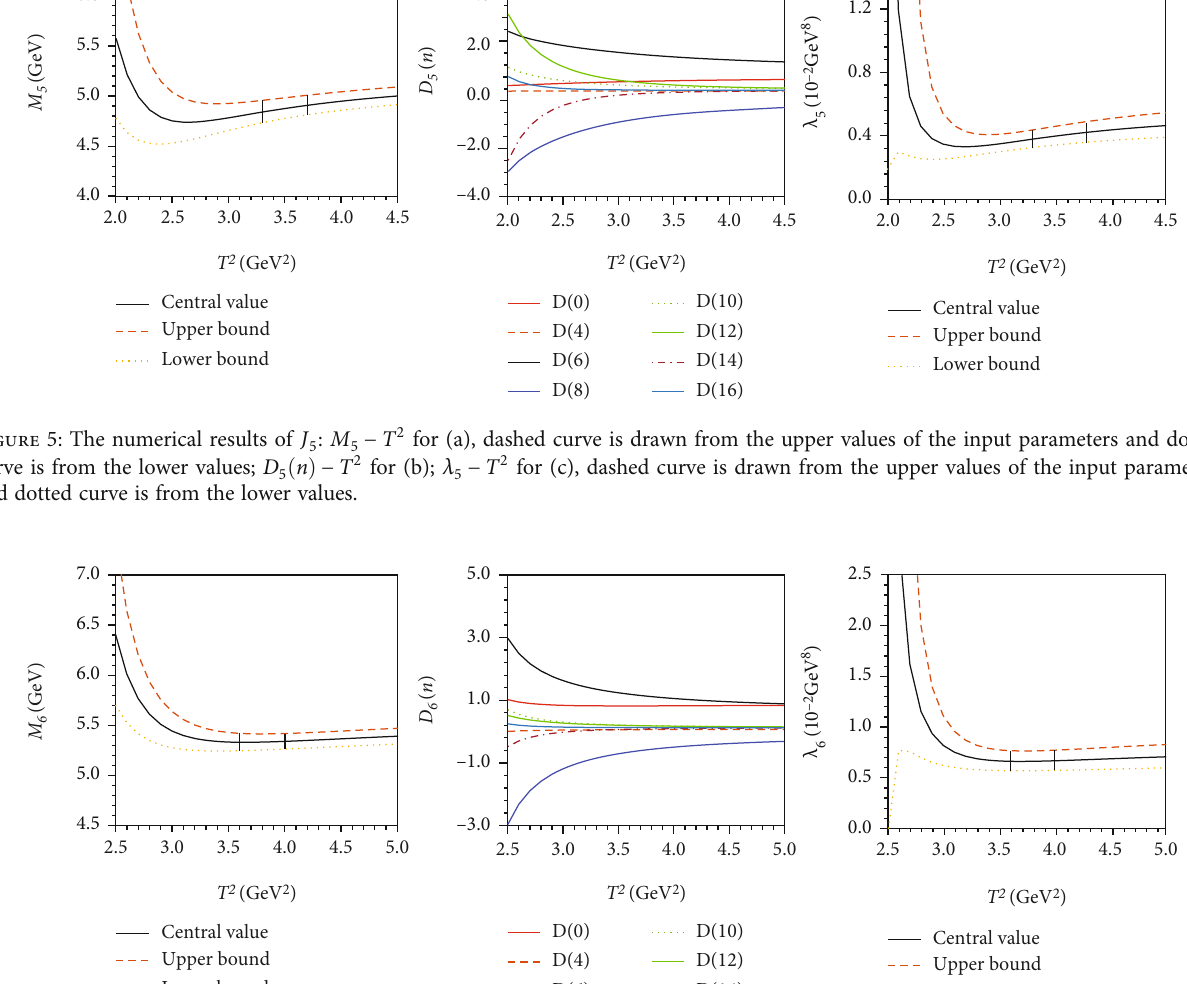
Figure 6: The numerical results of J curve is from the lower values; D and dotted curve is from the lower values.